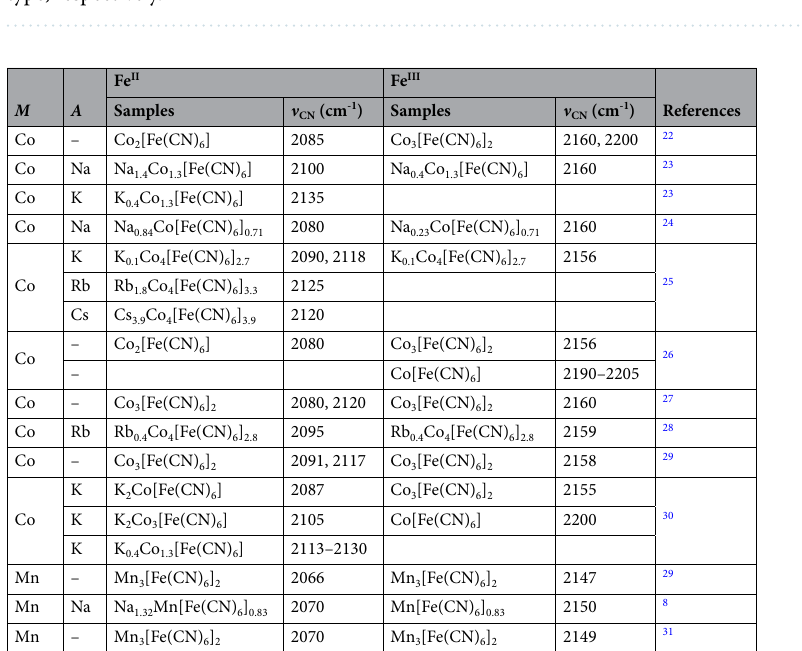
Figure 1. Oxidation processes in A x M [Fe(CN) 6 ] y . We call the upper and lower processes as M II -type and M III - type, respectively.